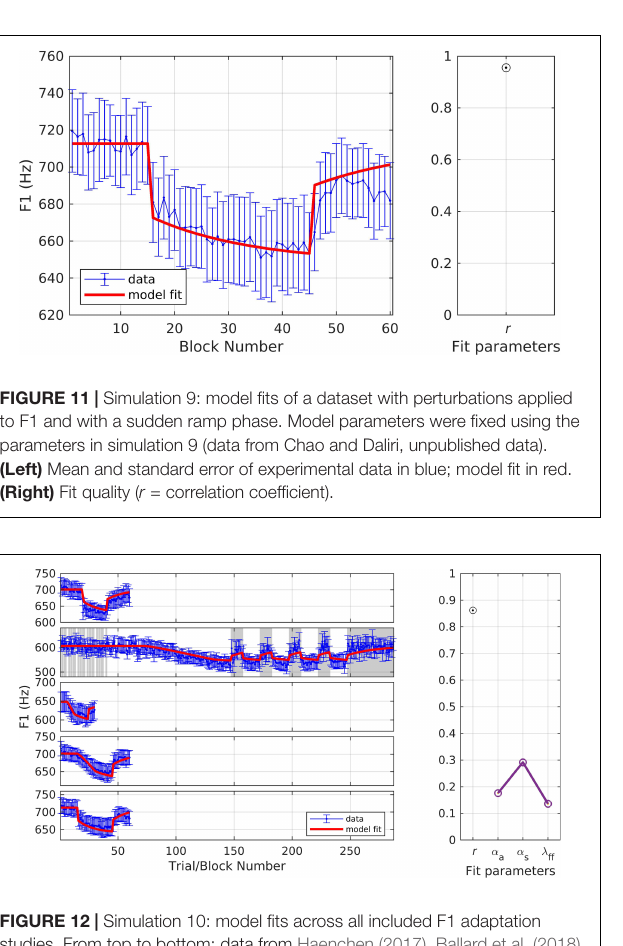
set of parameters. Figure 12 shows the resulting fits. The fit quality and optimized parameter values were: r = 0.86, α A = 0.18,